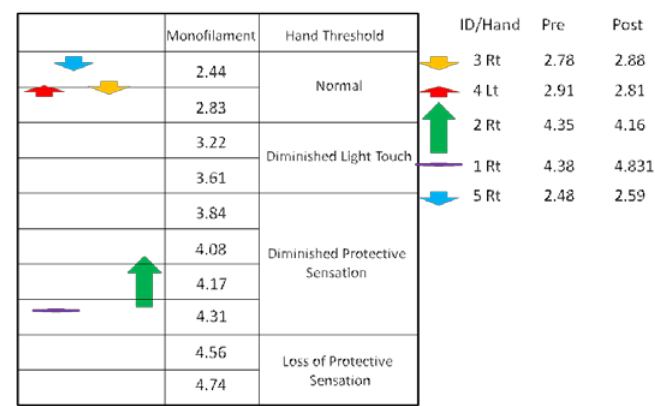
Fig. 8. Average “with glove” changes at each test site, pre to post training (smaller/greener values show improvement).